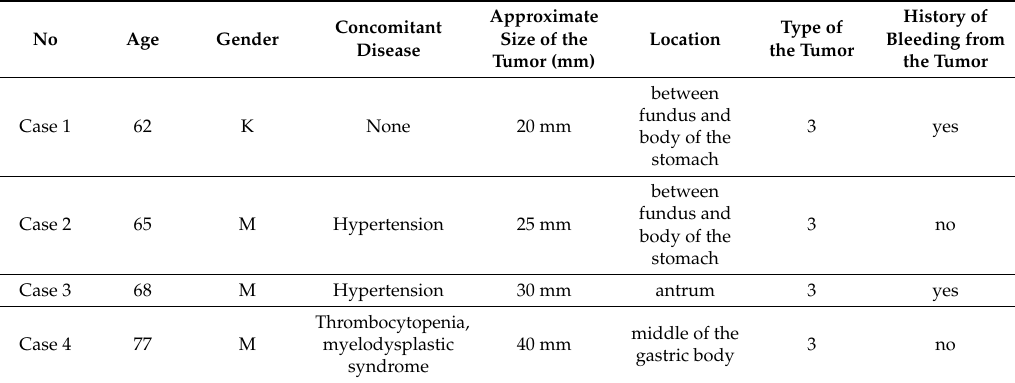
Figure 2. Endoscopic ultrasound evaluation of gastric GISTs. Typical appearance of GIST in endoscopic ultrasound. All tumors of a mixed echogenicity were located in the middle of the gastric wall and have a deep connection with muscularis propria . The average size was 28.75 mm. Table 1. Patient